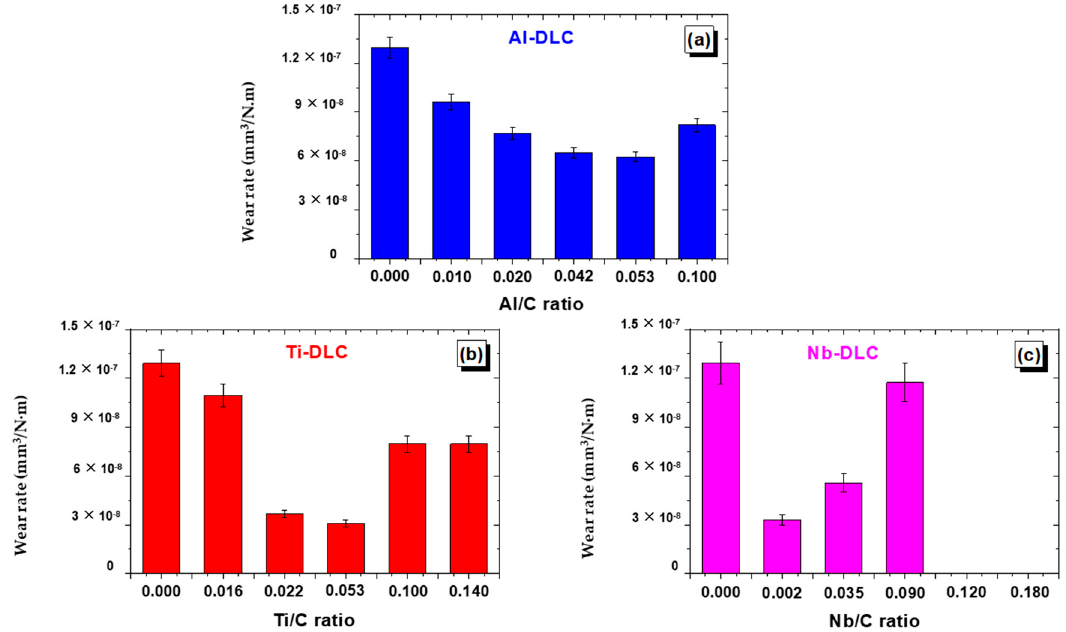
Figure 12. Variation of wear rate behavior of Me-DLC (Me = Al, Ti or Nb) as a function of Me/C